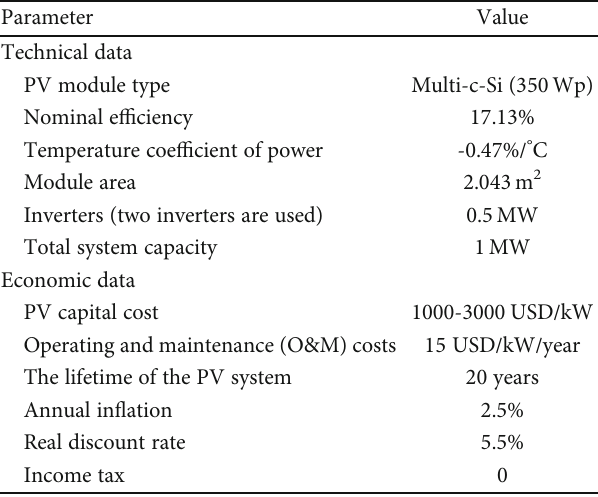
Table 1: Summary of the input data and assumption of the PV system and